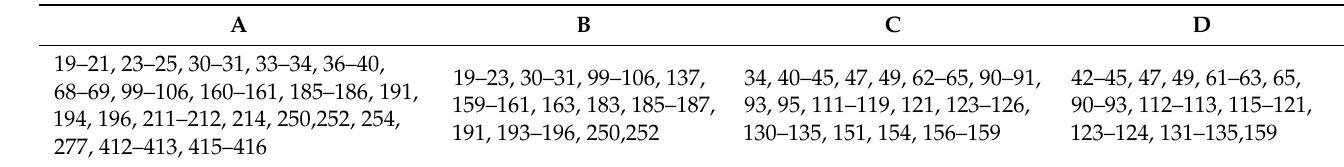
Table 1. List of the residues that are located at the interface between At SBP1 and At SAH7 after the molecular docking experiment and after the molecular dynamics simulation. (A) Interfacing residues of At SBP1 after the docking experiment, (B) interfacing residues of At SBP1 after the MD simulation, (C) interfacing residues of At SAH7 after the docking experiment, (D) interfacing residues of At SAH7 after the MD simulation.